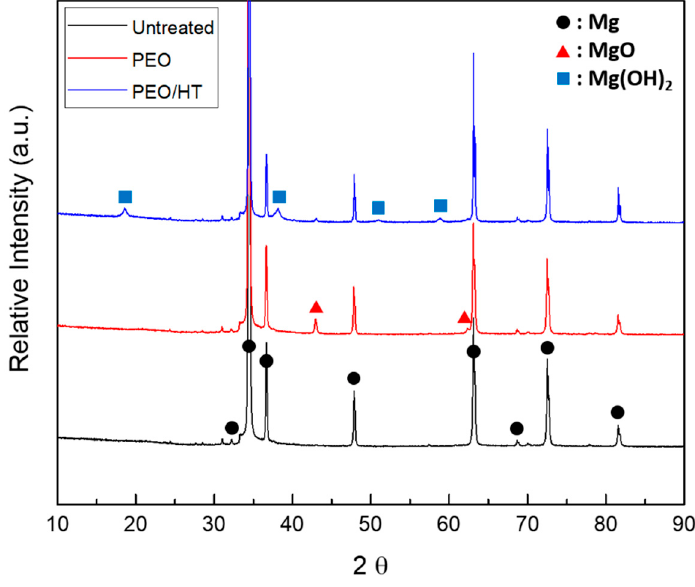
Figure 3. XRD patterns of the untreated Mg mesh, PEO-treated Mg mesh, and PEO/HT-treated Mg mesh.